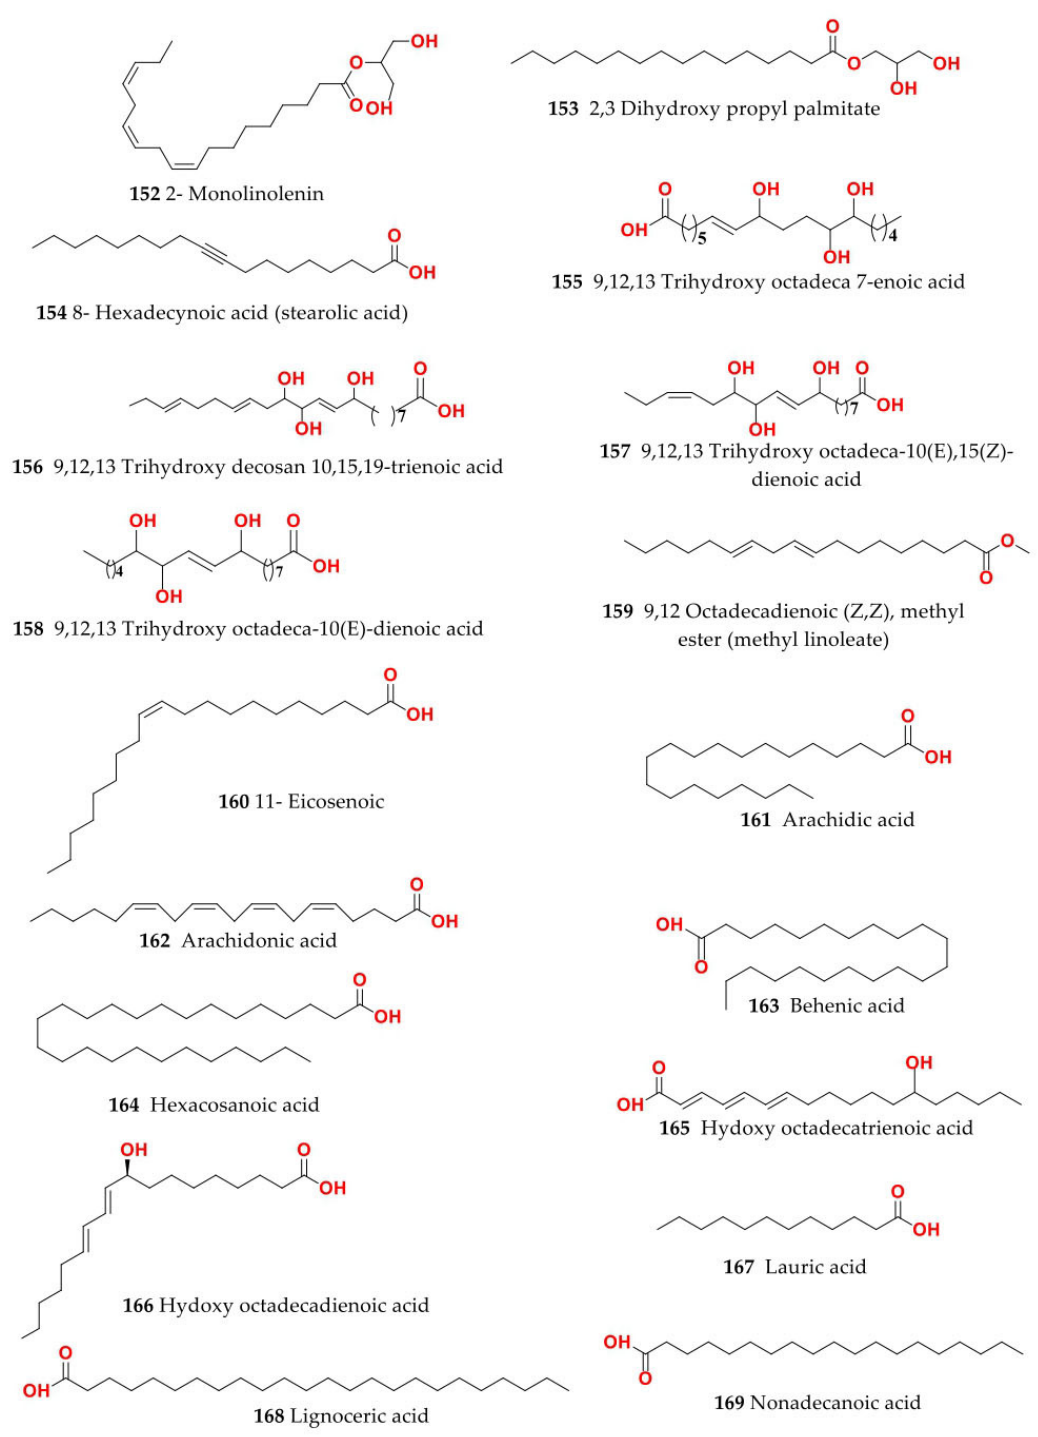
Figure 13. Chemical structure of fatty acids isolated from genus Salsola.